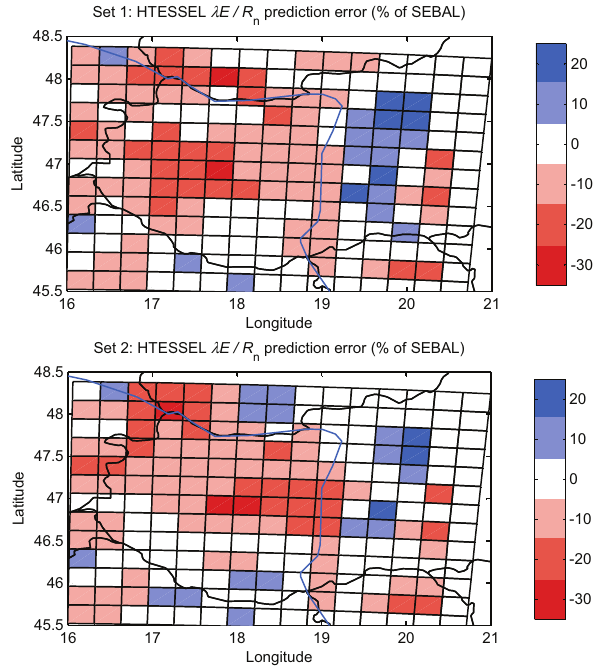
Fig. 10. Difference between SEBAL and HTESSEL seasonally averaged evaporative fraction, λE / R n as percentage of SEBAL λE / R n for initial condition Set 1 and 2, respectively. λE / R n has been derived by using the λE and R n over a 30 week period starting at week 13 and ending at week 43, 2005. The blue cells refer to λE / R n overprediction, the red cells to underprediction by the model.